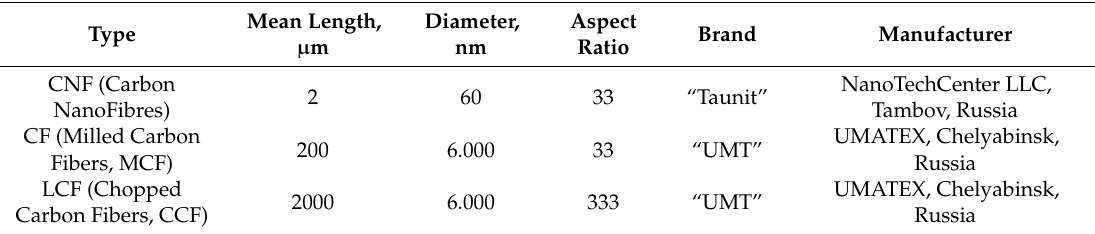
Table 1. Fibrous fillers used for the composite